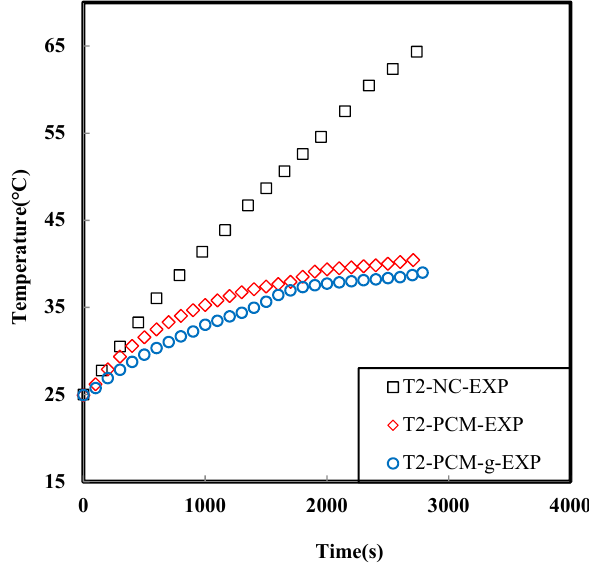
Figure 6. The comparison of the T 2 thermocouple under the different cooling technologies (NC: natural convection, PCM-g: PCM-graphite).